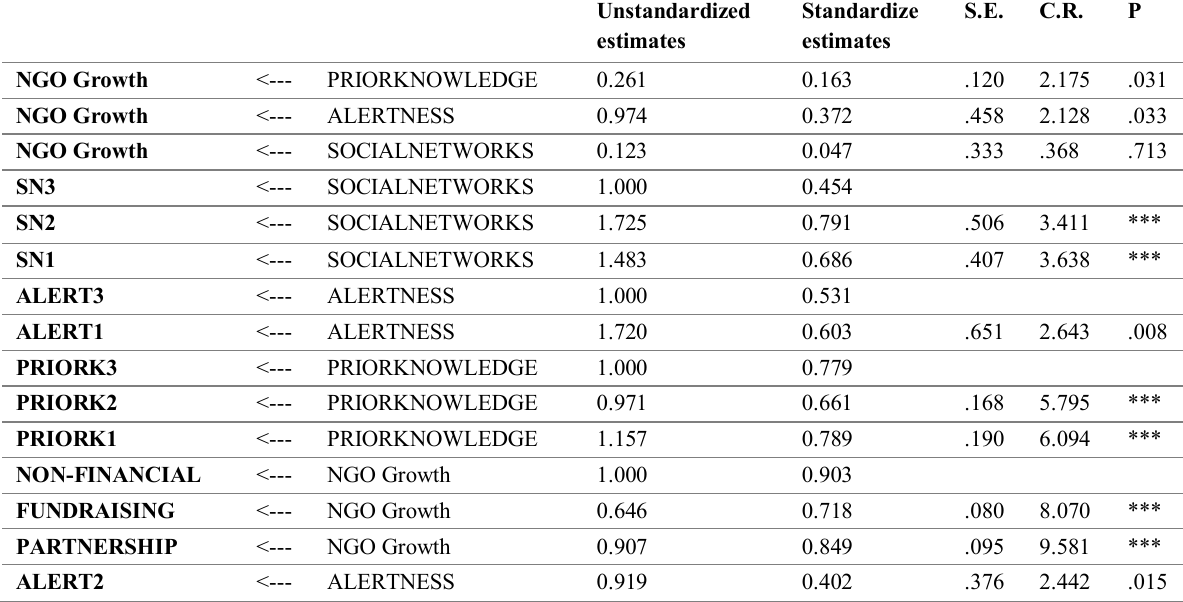
Table 4 : Standardized and unstandardized regression coefficient estimates of opportunity discovery dimensions